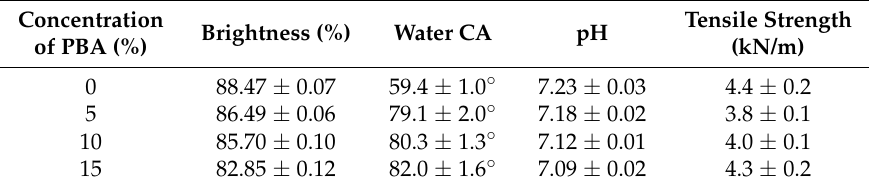
coated with 5, 10 and 15% of PBA,